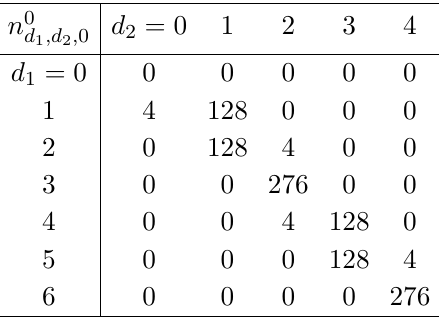
Table 2 . Low degree genus zero Gopakumar-Vafa invariants at base degree zero for the elliptically fibered Calabi-Yau threefold with 2 sections that arises from the toric data (6.1).